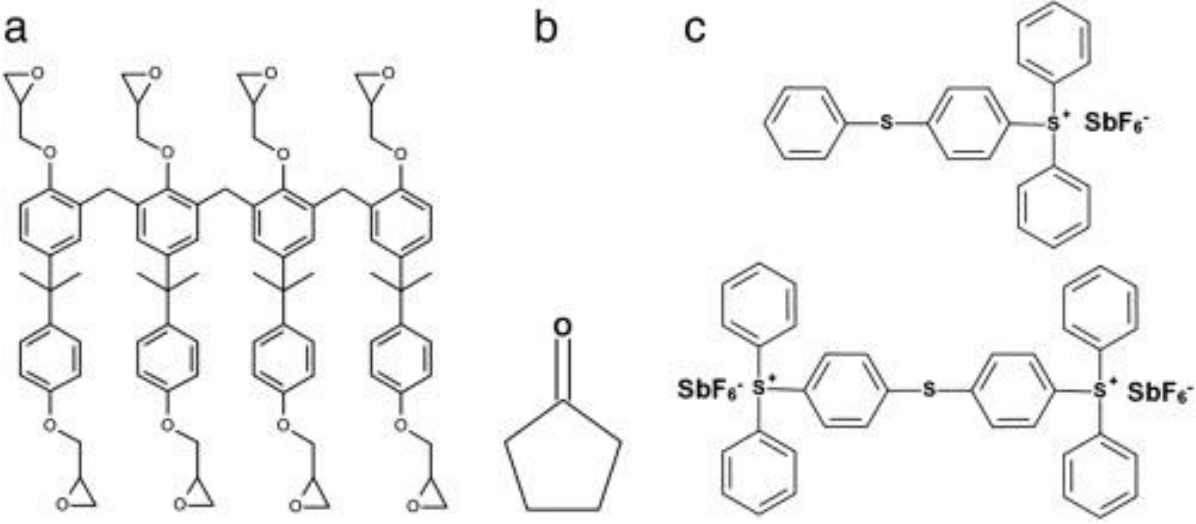
Figure 3. ( a ) Chemical composition of SU-8 photoresist. ( a ) SU-8 2075 comprises SU-8 monomer, ( b ) a solvent, cyclopentanone, and ( c ) a photoacid initiator, mixed triarylsulfonium hexafluoroantimonate salts. Reprinted from Nemani et al. [25] with permission from Elsevier.